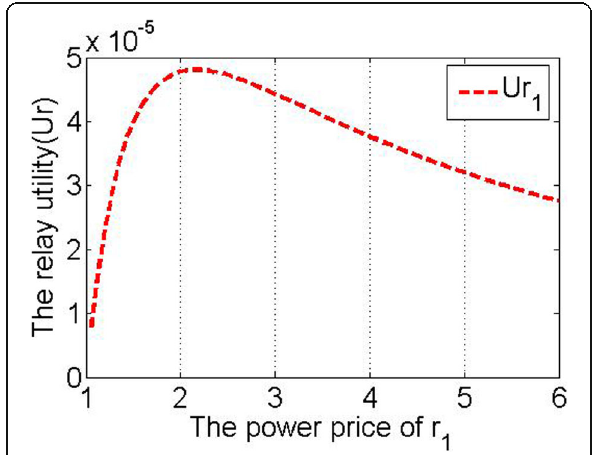
of r 1 varies with its power price v r 1